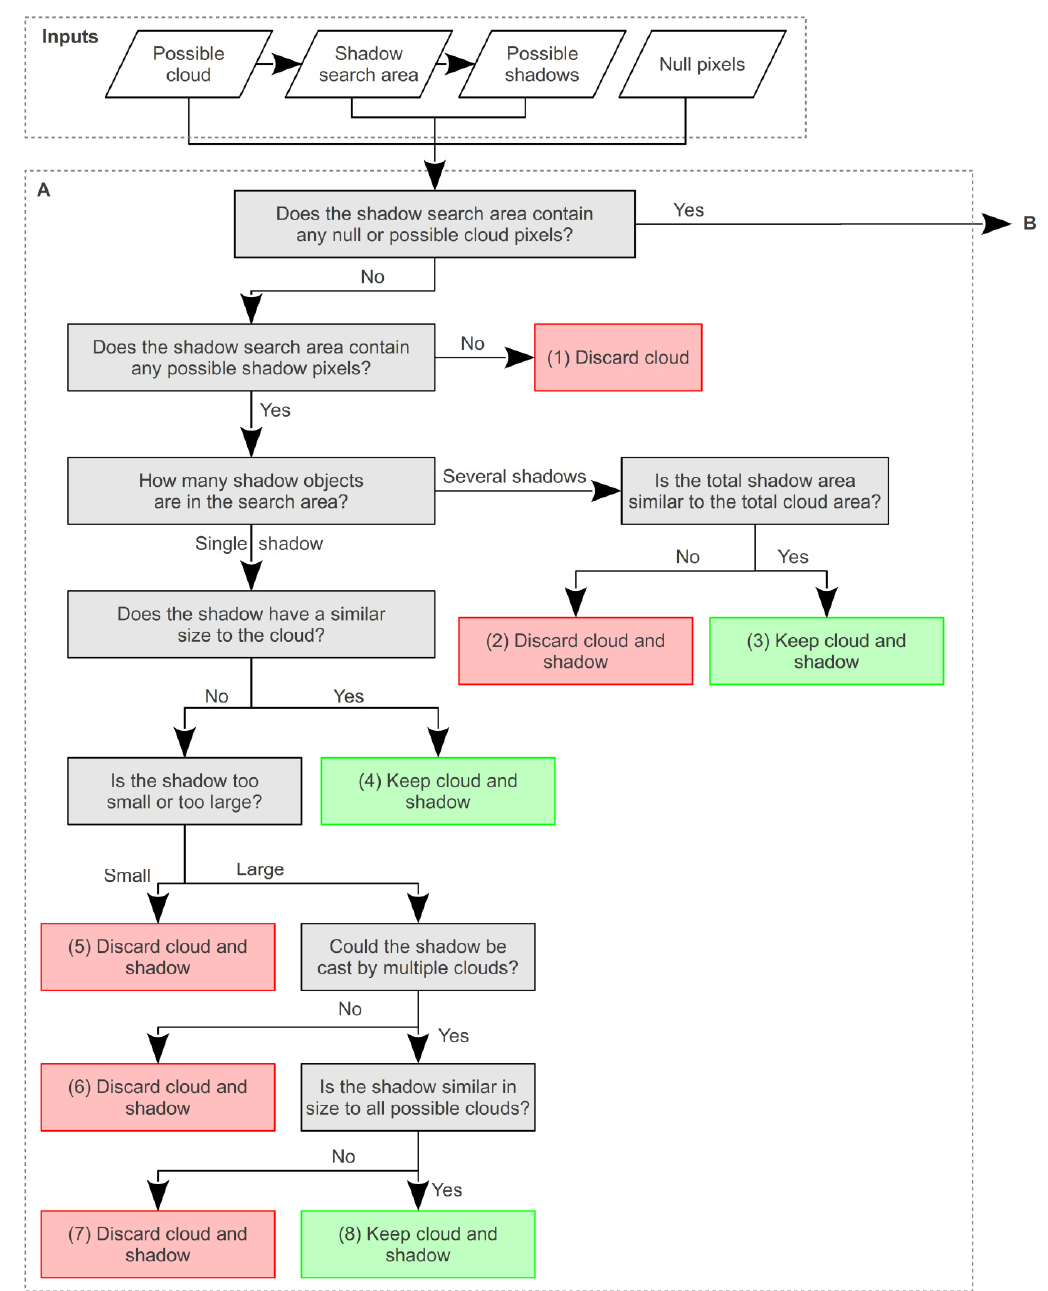
Figure 9. The decision tree used to iteratively refine possible cloud and cloud-shadow objects. Any size comparison mentioned in the tree is performed using Equations (3) and (4). The numbers in the red (reject), green (accept) and yellow (no decision) rectangles identify the 19 different end-points to the decision tree. ( A ) The simplest case; ( B ) The more complicated case where possible clouds are located in the shadow search area; ( C ) The case complicated only by null pixels located in the shadow search